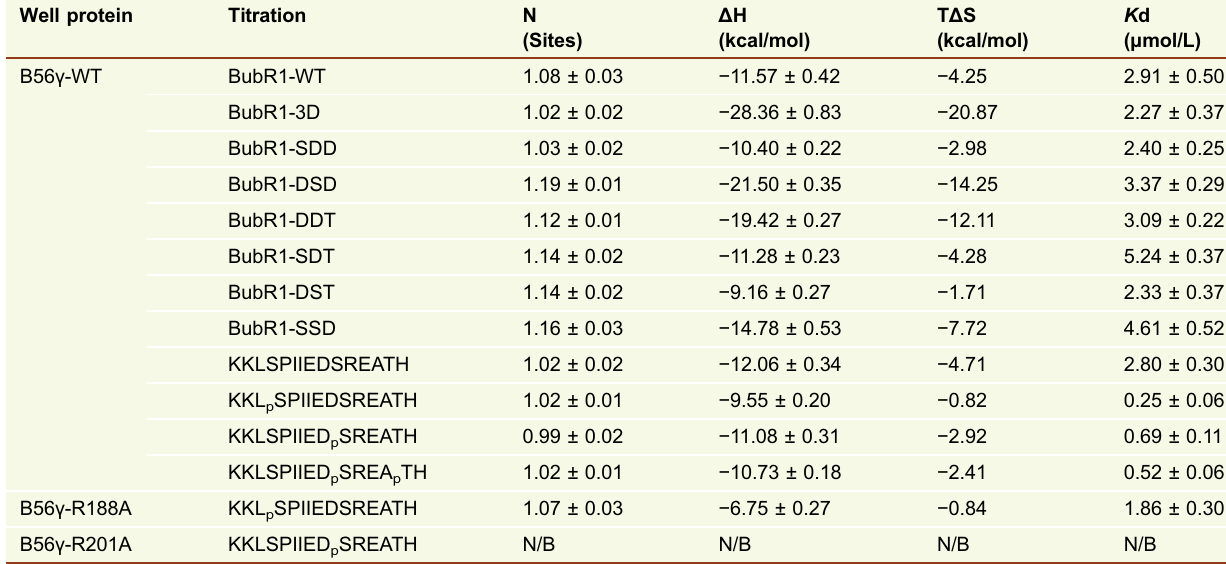
Table 2. Summary of ITC analysis of the interactions between PP2A B56 γ 1 and phosphorylated or phosphor-mimicking BubR1 proteins/peptides Well